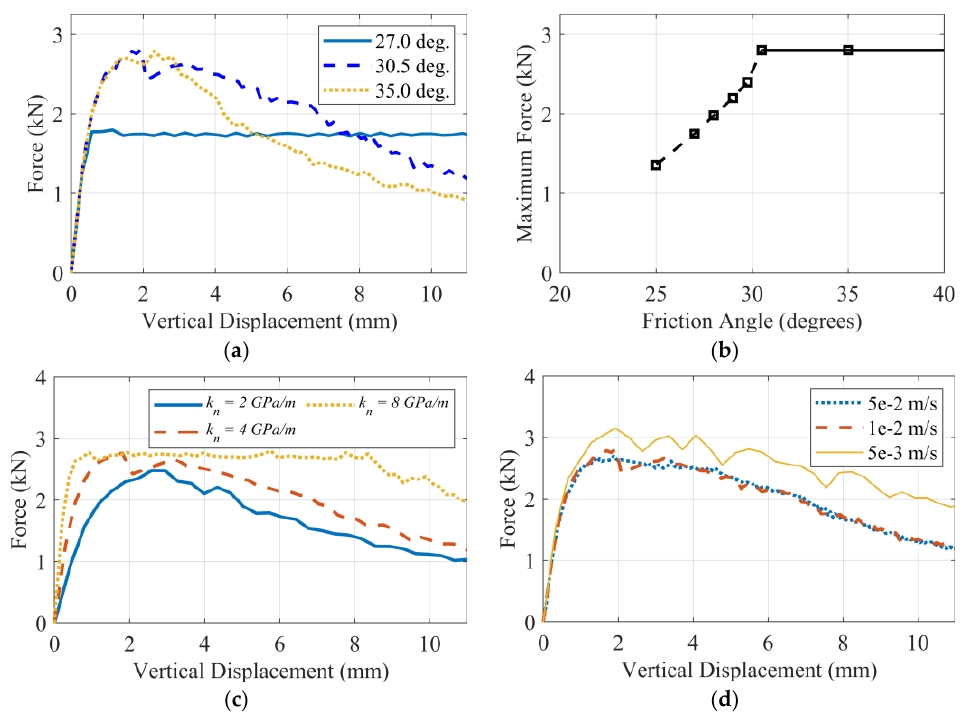
Figure 9. ( a ) Influence of the contact friction angle only the macroresponse of the arch and ( b ) load- carrying capacity; sensitivity analysis on the ( c ) contact stiffness and ( d ) prescribed velocity on the loading plate.